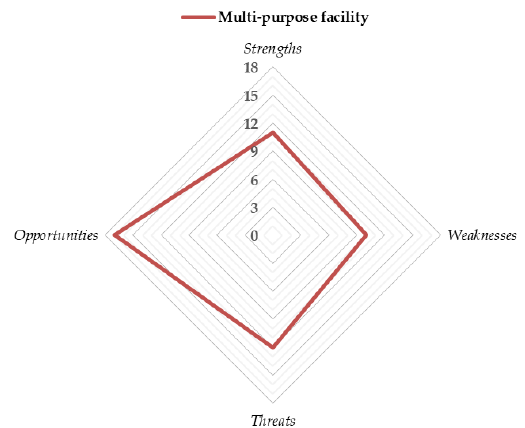
Figure 11. The quantitative results of SWOT analysis for reclamation methods aimed at com- bined/multidisciplinary repurposing of underground workings.